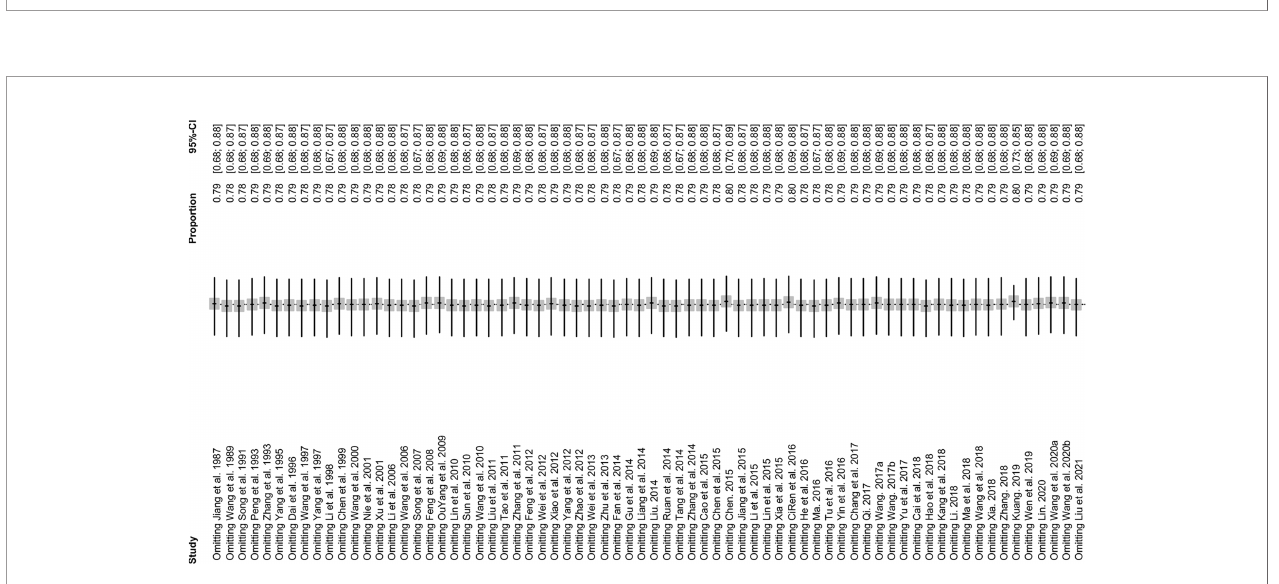
FIGURE 3 | Funnel plot with pseudo 95% con fi dence interval limits for the examination of publication